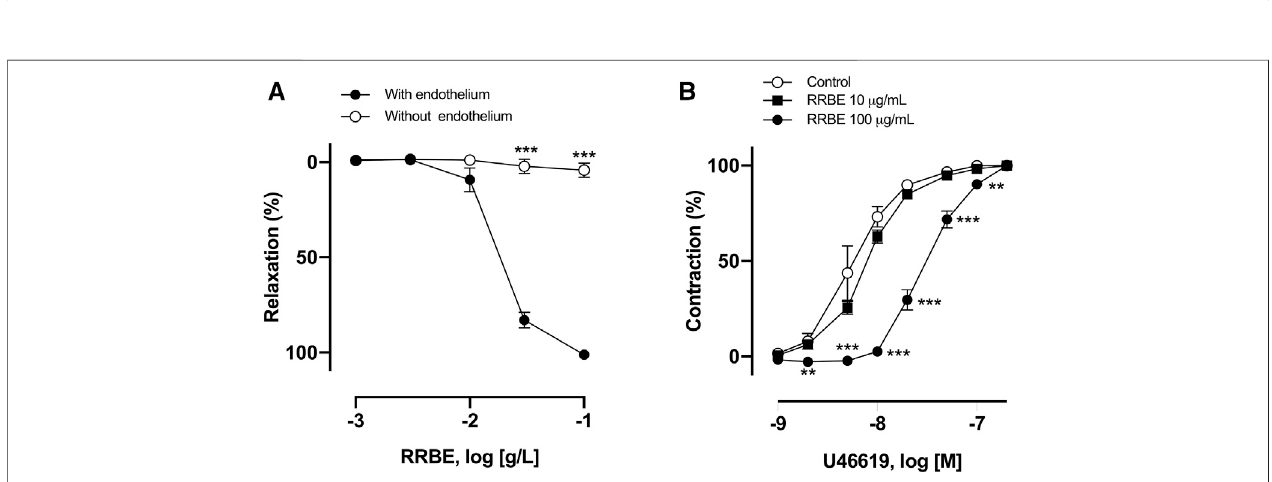
FIGURE 2 | RRBE induced endothelium-dependent relaxation and suppressed contraction in the porcine ’ s coronary ring. (A) Intact and endothelium-denuded rings were contracted using U46619 before the addition of increasing concentrations of RRBE (1 μ g/ml to 100 μ g/ml) to construct concentration-relaxation curves. *** p < 0.001 vs theendothelium. (B) Coronaryartery ringsweretreatedwithRRBE(10 μ g/mland100 μ g/ml)beforeconstructing theconcentration – contractioncurvein response to U46619. Results are presented as mean ± SEM of fi ve to seven experiments. *** p < 0.001 vs control. ** p < 0.01 vs control.